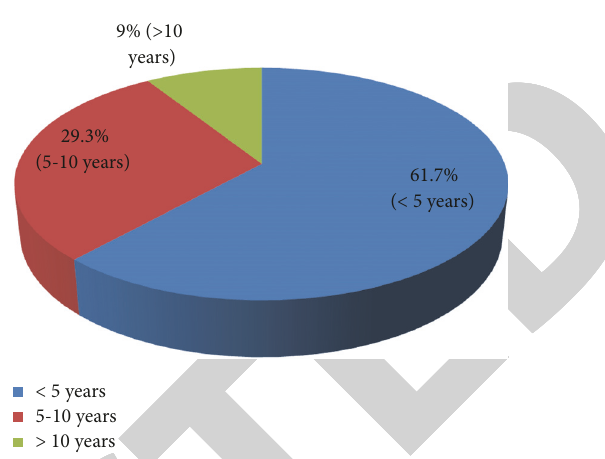
Figure 2: Duration of chronic kidney disease among patients attending the renal clinic of Tikur Anbessa Specialized